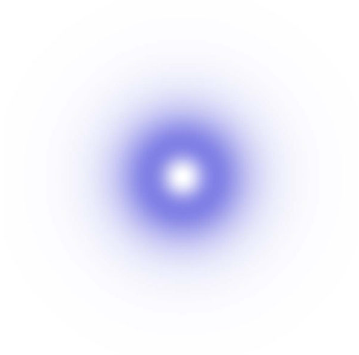
Fig. 2 Theenergydensityofthesolution(29),displayedwiththeinten- sity of the blue color increasing with the increasing values of the energy density